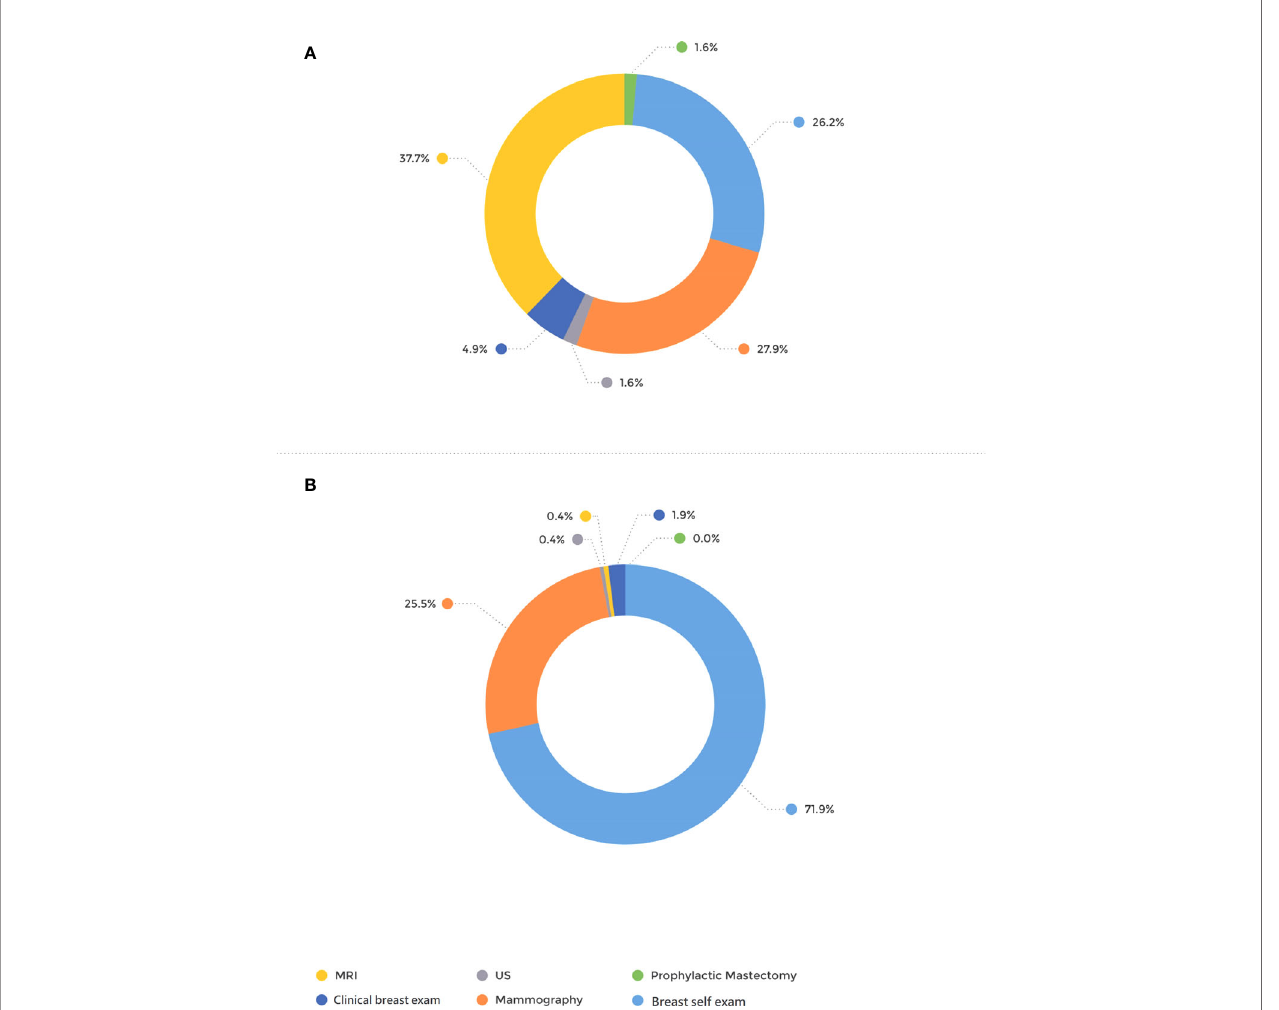
FIGURE 1 | Mode of tumor detection. (A) BRCA-preDx awareness group. (B) BRCA-postDx awareness group. MRI, magnetic resonance imaging; US,